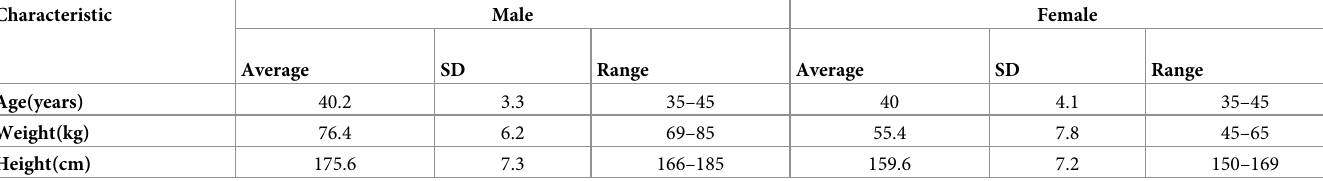
The table describes the average, standard deviation and range of age, weight and height of the